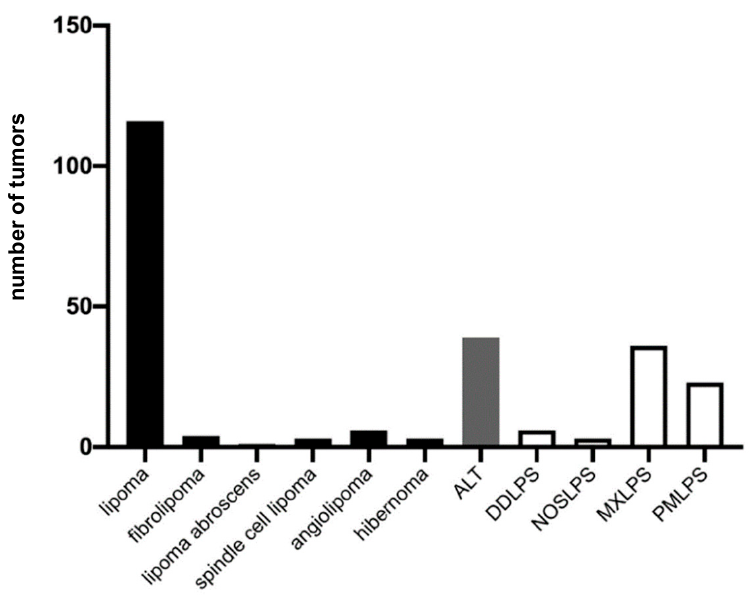
Figure 1. Tumor entities according to the final histologic diagnosis. Lipomatous tumors are further subclassified, and the number of subentities is depicted. Benign entities are depicted in black, intermediate in gray, and malignant tumors in